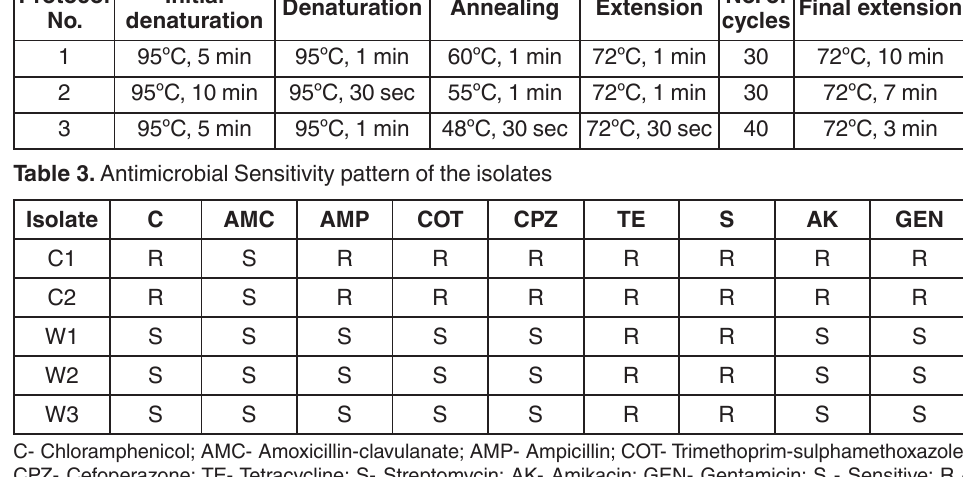
table 2. PCR cycling conditions used for the study Protocol No.